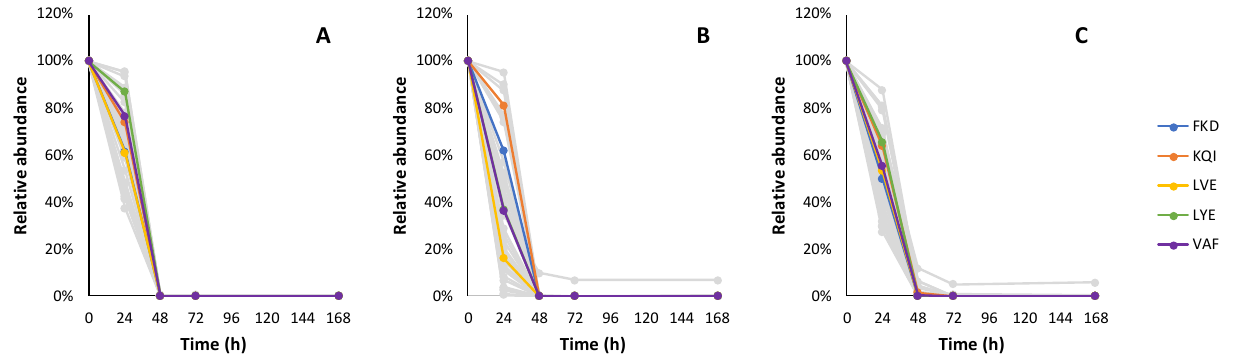
Figure 4. The relative consumption trends of 41 tripeptides in fermentation with Lalvin ICV Opale 2.0™ ( A ), Lalvin Persy™ ( B ) and Lalvin QA23™ ( C ) of the modified synthetic must with added BSA hydrolysate as the peptide source. The five tripeptide candidates with the highest abundance are shown in colour. Other tripeptide candidate sequences and their observed relative consumption trends are shown in Table A5.